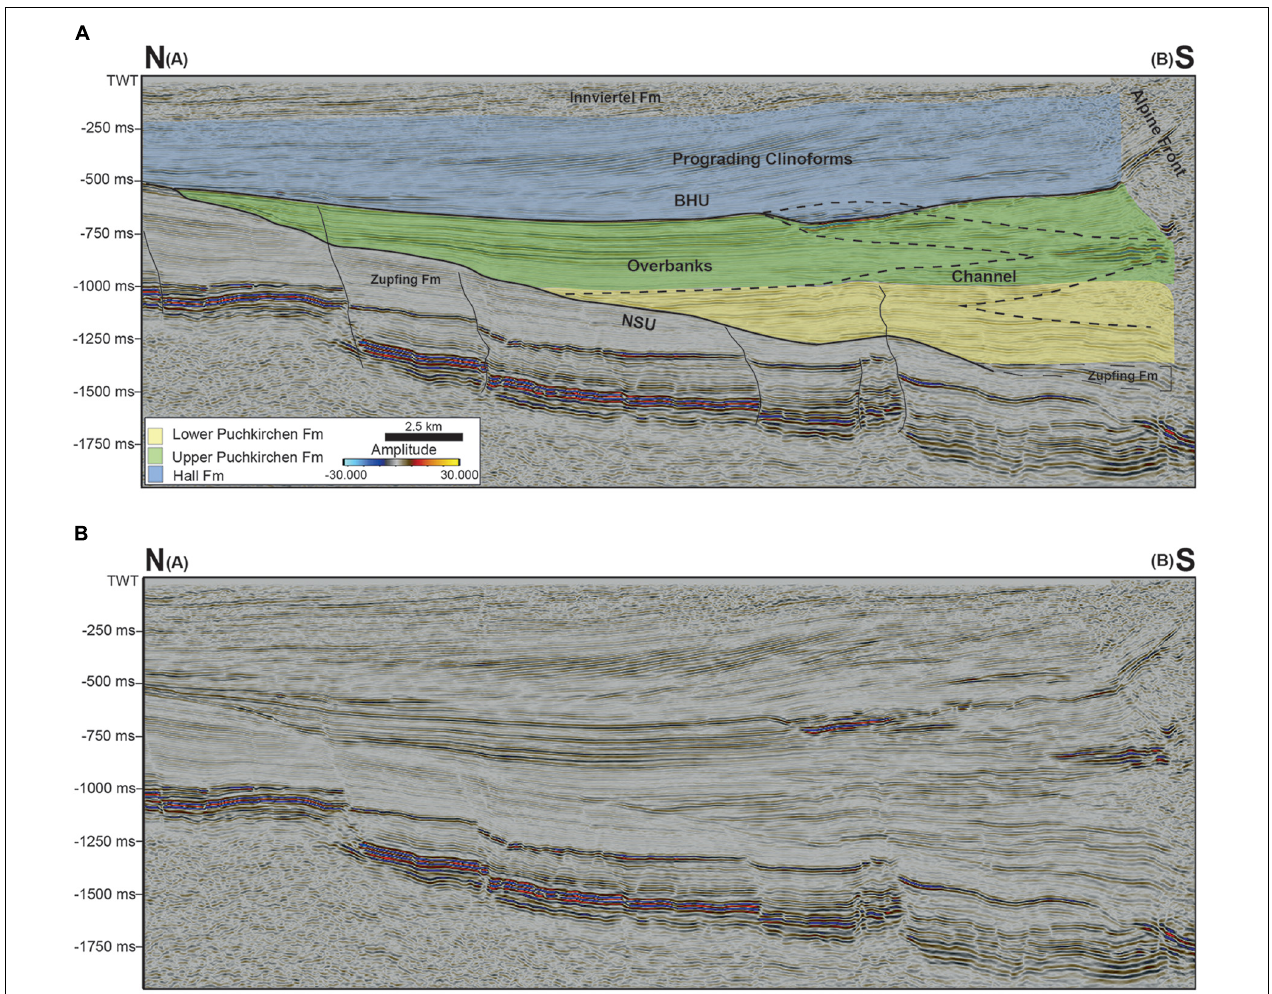
FIGURE 2 | Cross section (N – S) through the Upper Austrian Molasse Basin (for position see Figure 1 ) showing the lateral migration of the main channel belt in the Puchkirchen and Hall formations (black, dotted lines). On the northern slope the NSU (thick black line) is visible with the Zupfing Formation below it. The wide ( ≤ 15 km) overbanks of the UPF and BHF north of the channel are illustrated. The BHU is characterized by truncated reflectors in the channel and two strong reflectors on the overbanks. Above the BHU a small segment with transparent reflectors is visible before clinoforms start to prograde from the southern margin into the basin. (A) Interpreted seismic cross section; (B) uninterpreted seismic cross